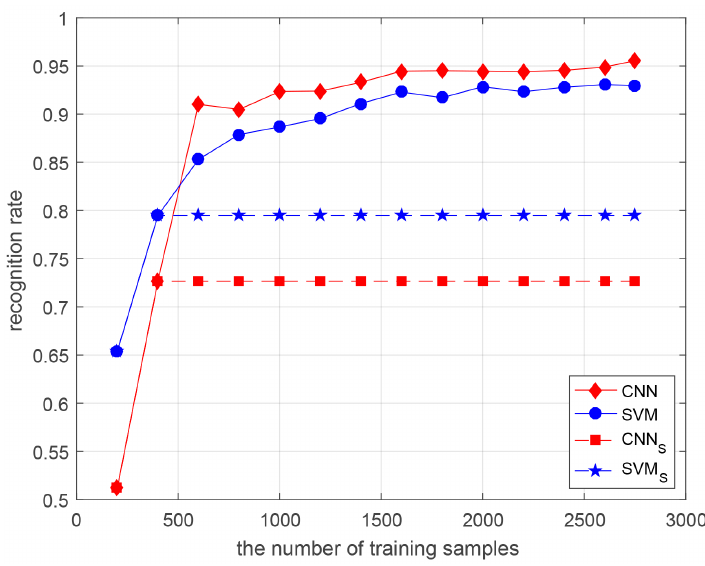
Figure 10. The recognition performance of different ATR models. The dotted line represents the recognition performance achieved by the two ATR models when facing the small sample set. The solid line indicates the recognition rate of ATR models when the number of SAR target samples is